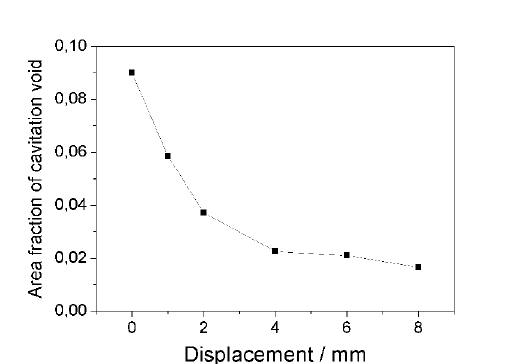
Figure 11. Area fraction of cavitation void as a function of the displacement from the fractured tip of the fractured specimen shown in Figure 8 b).